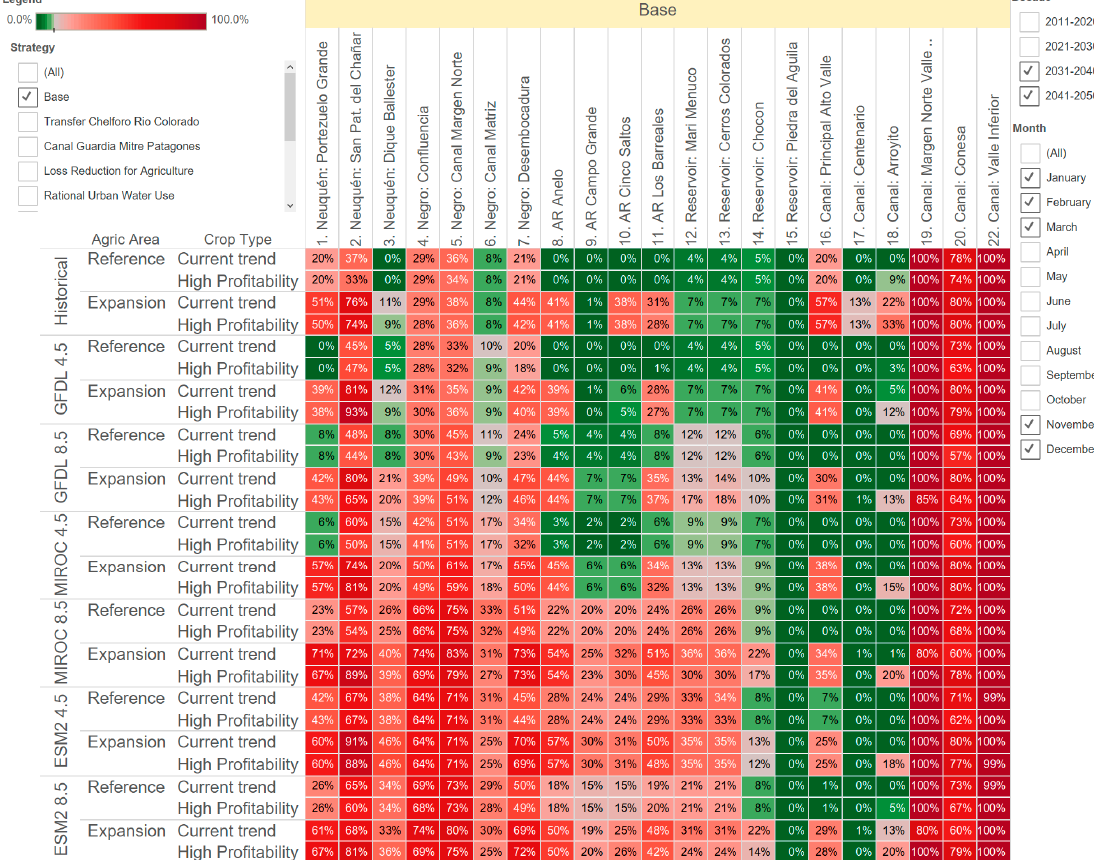
Figure 6. Current management in long term: The color dimension of the visualization is designed so shades of green means the performance metrics fails 10% (or less) of the time. Shades of red show the performance metric fails between 11% and 100% of the time (darker shades of red when close to 100% and lighter shades of red when closer to 11%) [34].